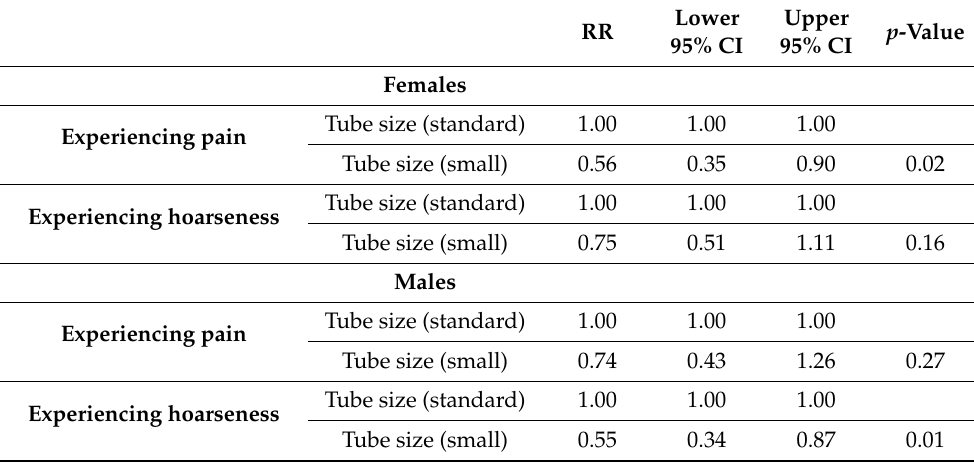
Table 3. Time-adjusted relative risk estimates with 95% confidence